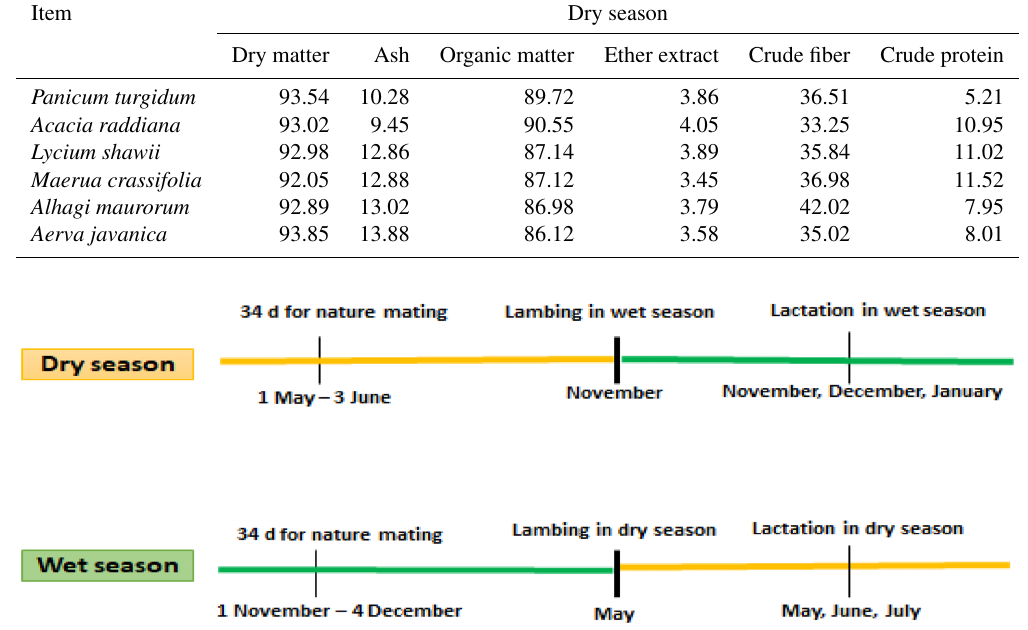
Figure 1. Schematic representation of experimental design: two groups according to the time of the year of their breeding season and periods of lambing and lactation.